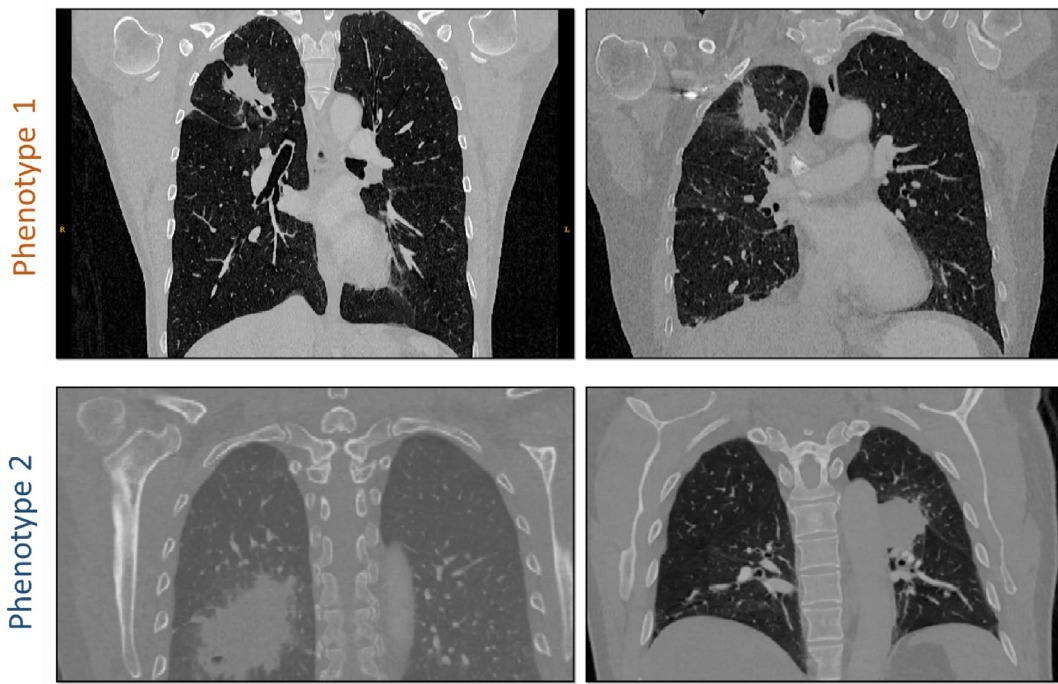
Figure 7. Representative tumors from the two phenotypes. Examples demonstrate the relatively smaller, elongated shape, convex borders and adjacent linear opacities for phenotype 1 versus the larger size, ground- glass, irregular, and indistinct border characteristics for phenotype 2 suggestive of potential inflammatory changes that may be related to their observed worse PFS and OS